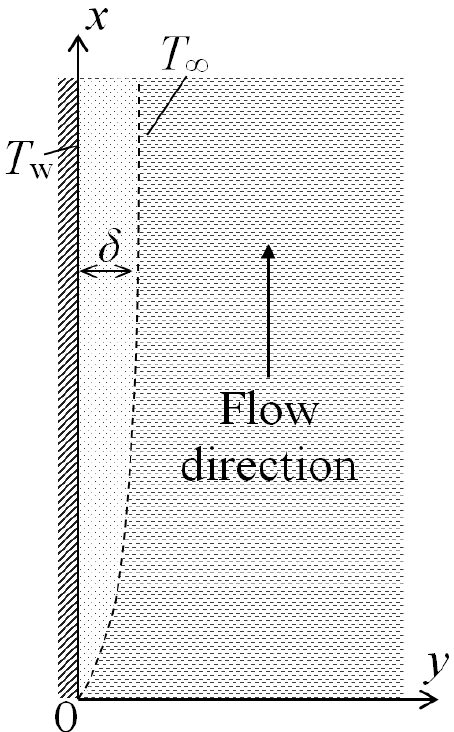
Figure 1. Schematic of two-dimensional natural convection near a heated vertical wall: x —flow direction, y —normal direction, δ —boundary layer thickness, T w —wall temperature, T ∞ —temperature outside of the boundary layer.